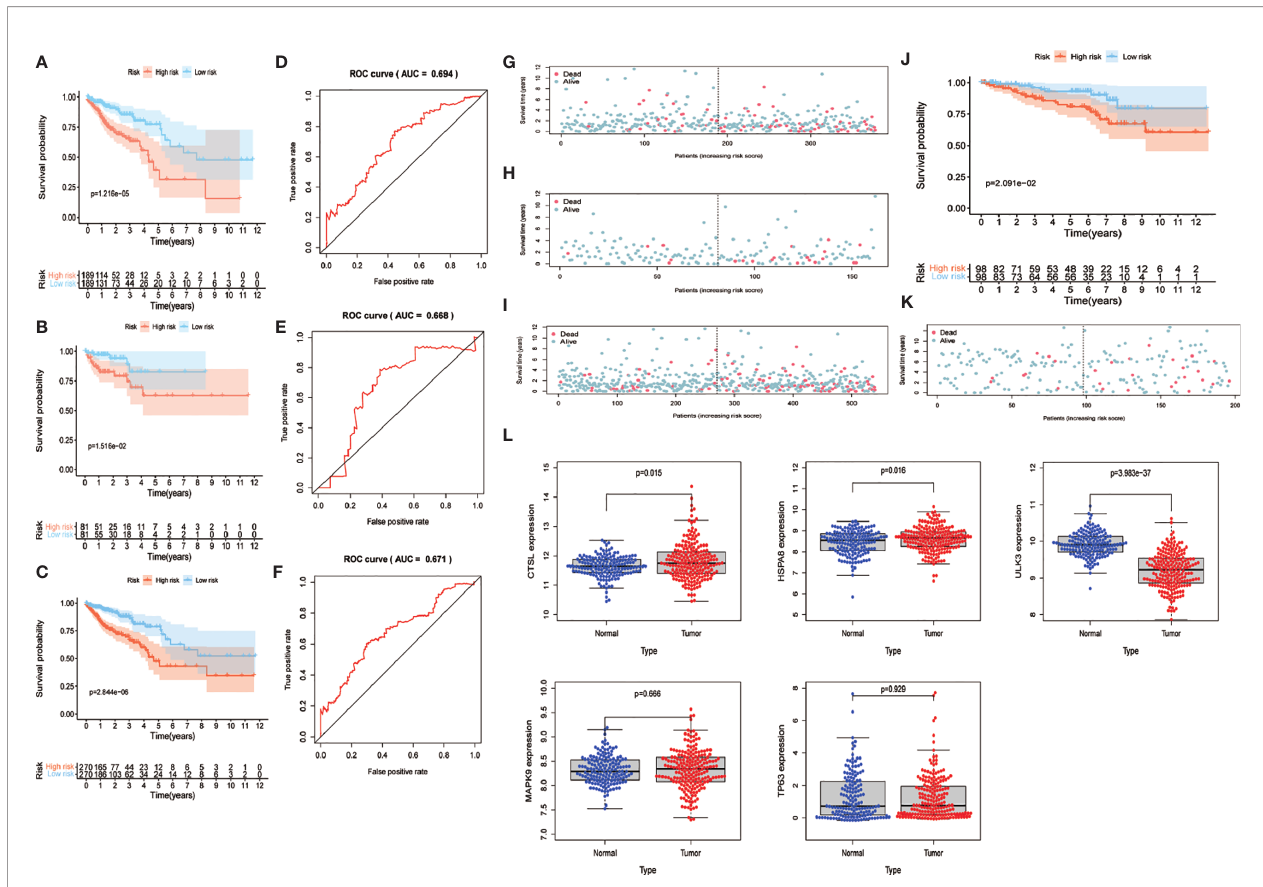
FIGURE 4 | Validation of risk parameters. (A – C) Training set, test set and combined set survival curves. Kaplan-Meier plots indicate the survival status of patients in the high and low risk groups, with shorter overall survival time in the high risk group compared to the low risk group. (D – E) Training set, test set and combined set ROC curves with AUC=0.694, AUC=0.668 and AUC=0.671. (G – I) Survival status of training set, test set and combined set. Death cases in high and low risk groups are shown in blue for survival and red for death. (J) GSE87211 survival curves. The lowrisk group has better OS performance. (K) GSE87211 survival status. (L) Expression of 5 genes in normal and tumor samples. OS, overall survival; ROC, receiver operating characteristic; AUC, The area under the curve.